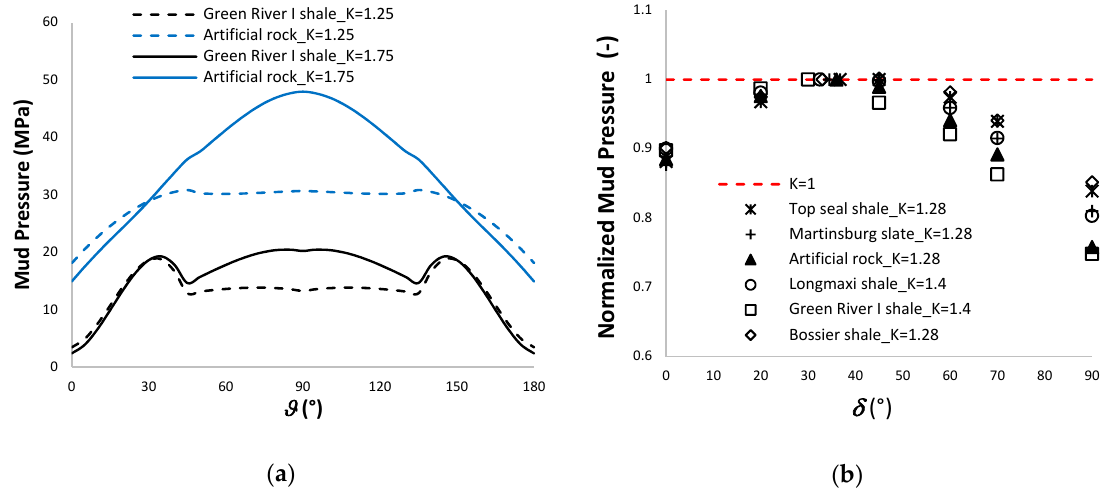
Figure 15. ( a ) Mud pressures calculated at δ = 90° with the weakness plane model and Hoek and Brown criterion, when K = σ MAX / σ min = 1.25 K = σ MAX / σ min = 1.75 ( σ min = 40 MPa, P f = 35 MPa) for the Artificial rock. Comparison with the mud pressure (P_mud) calculated with the Mohr Coulomb criterion when K = 1.25. ( b ) Extent of the instability predicted by the weakness plane model (red circles) and the Hoek and Brown criterion (red arcs), when K = σ MAX / σ min = 1.25. The weakness plane model predicts local instability. The Hoek and Brown criterion predicts that half of the circumference of the wellbore is unstable.